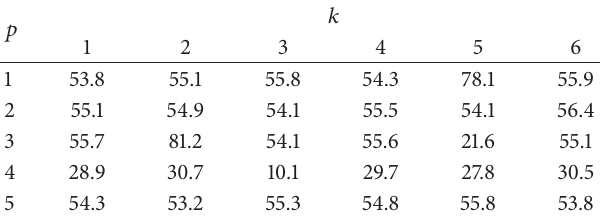
Table 1: Temperature